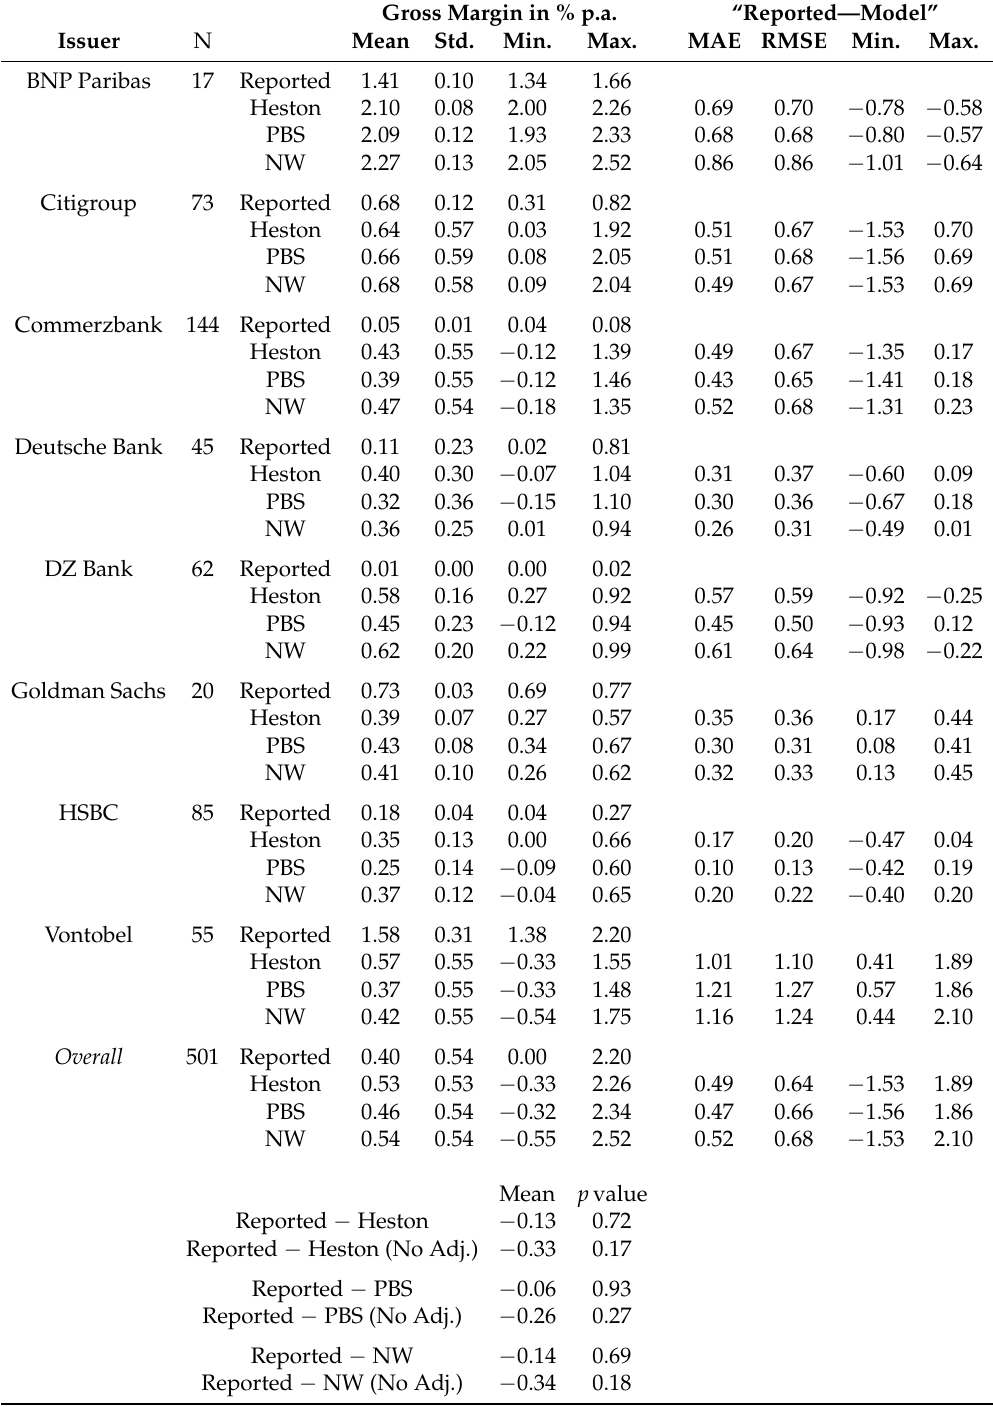
Table 2. Result Summary Statistics for Discount Certificates. Gross Margin in %